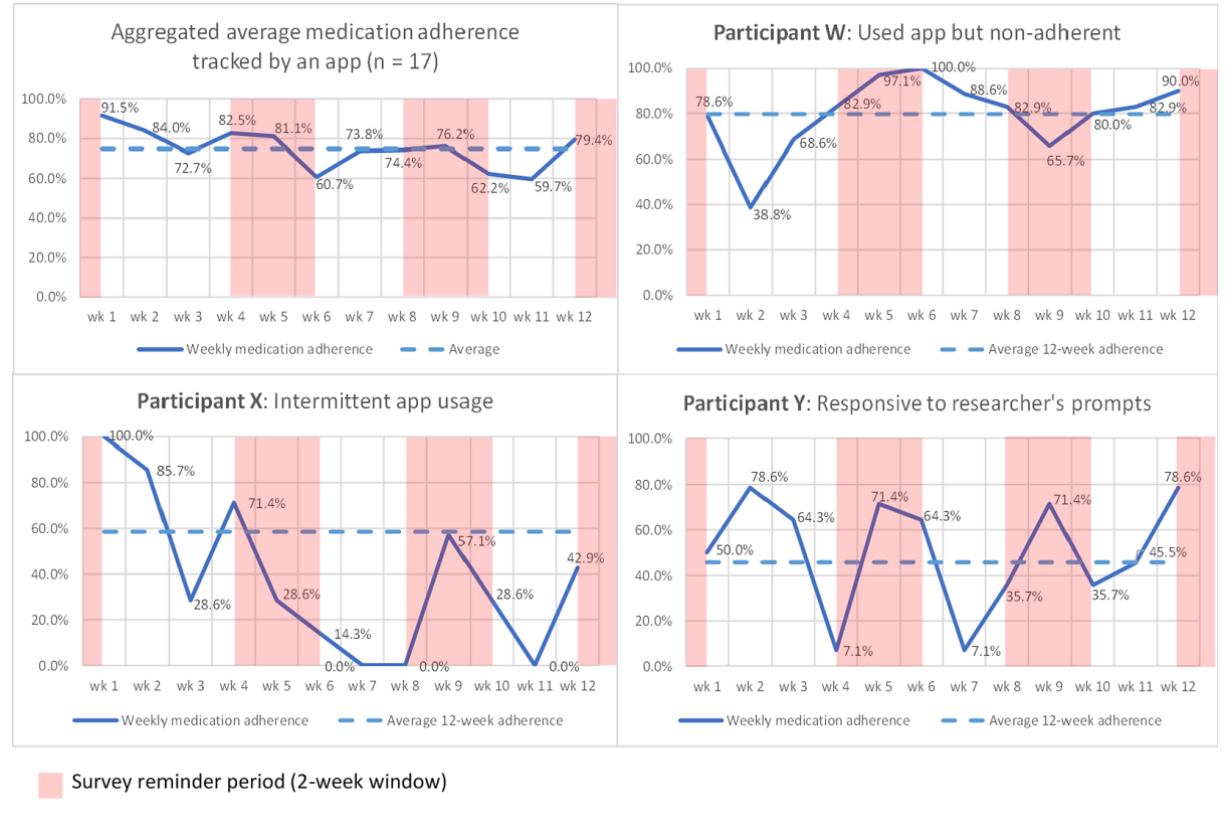
Figure 3. Weekly medication adherence over 12 weeks, extracted from participants’“Medisafe” reports.